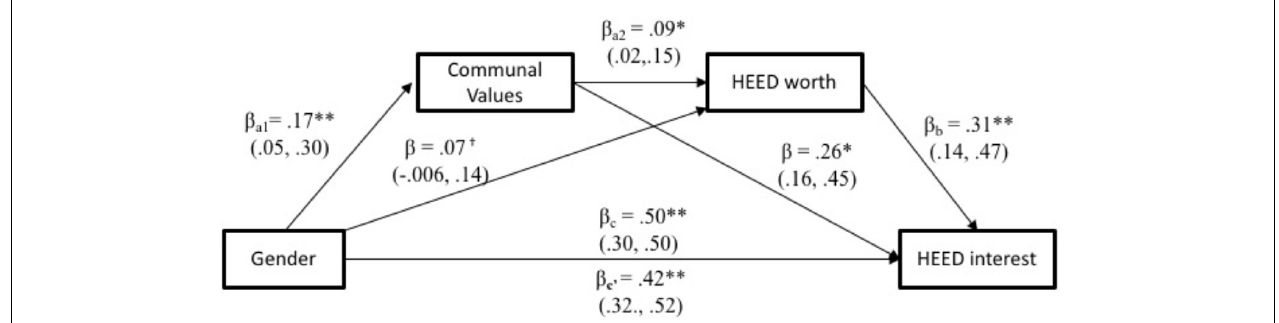
FIGURE 6 | Serial Mediation model for HEED variables in Study 2. All paths control for agentic values, interest in STEM, and societal worth of STEM. ∗∗ p < 0.01, ∗ p < 0.05, † p < 0.10. 95% confidence intervals in the brackets.